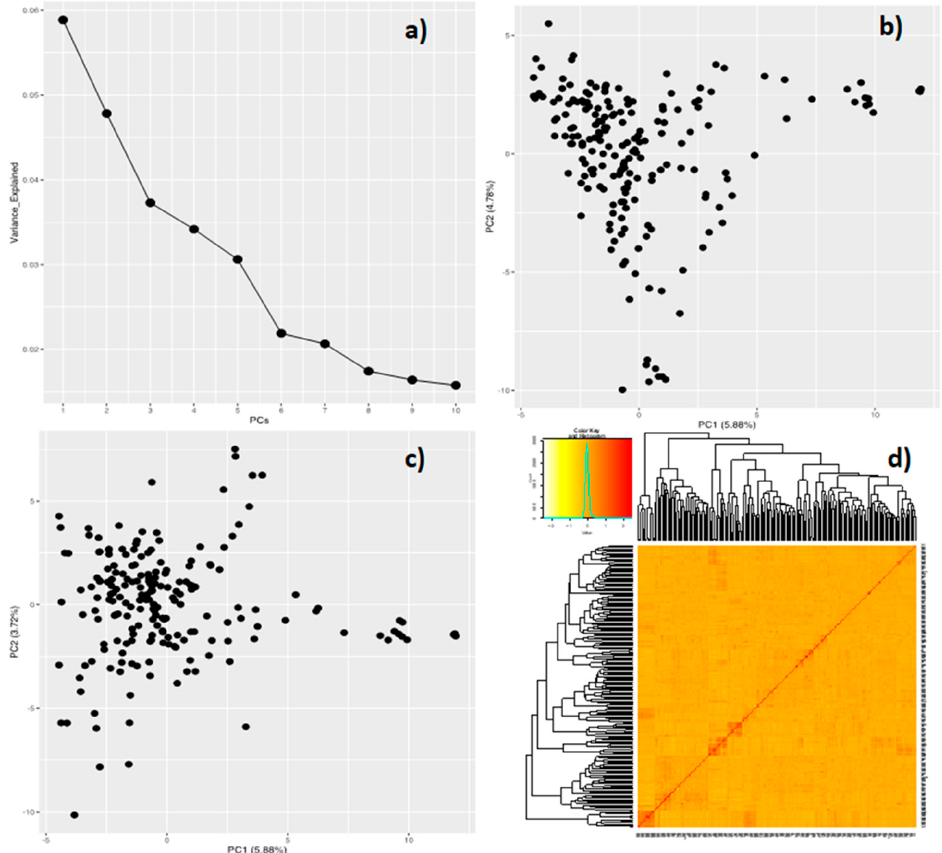
Figure 3. Principal component analysis ( a – c ) of AYB population and heatmap plot of kinship matrix ( d ) of 195 African yam bean accessions genotyped with the 2491 DArTseq SNPs.